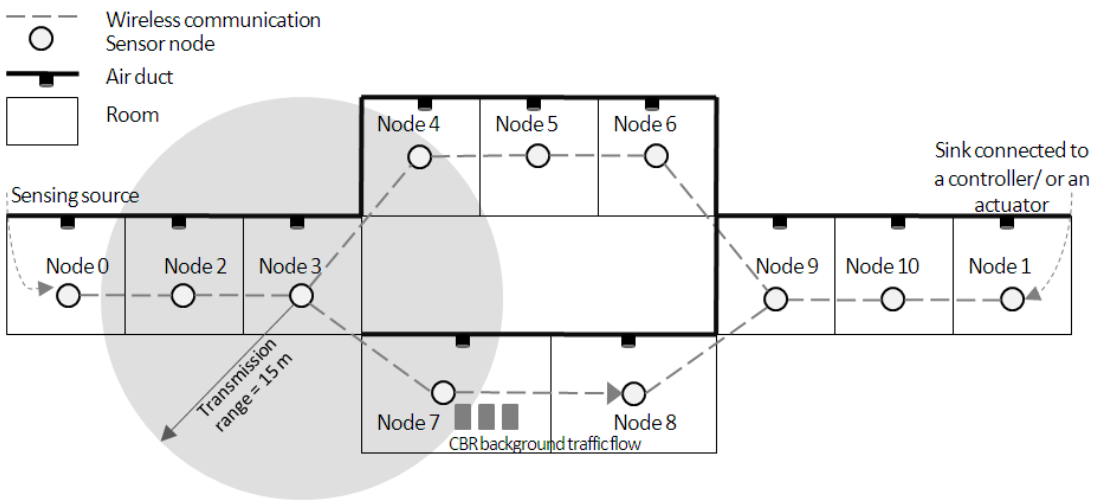
Figure 2. WSAN simulation